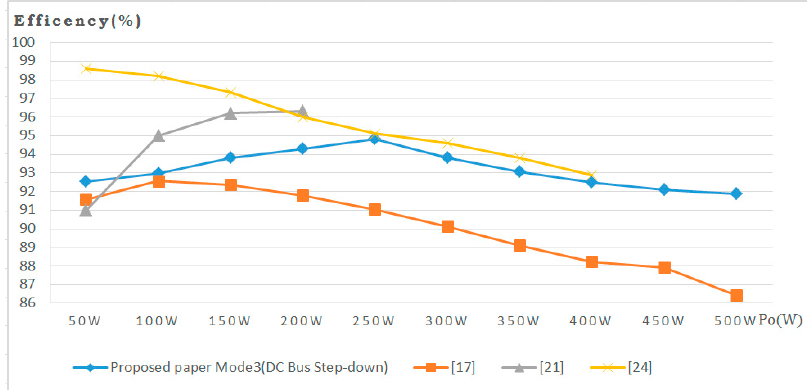
Figure 16. Efficiency comparison of proposed method and methods proposed in Refs. [17,21,22] in step-up mode. Energies 2020 , 13 , x FOR PEER REVIEW